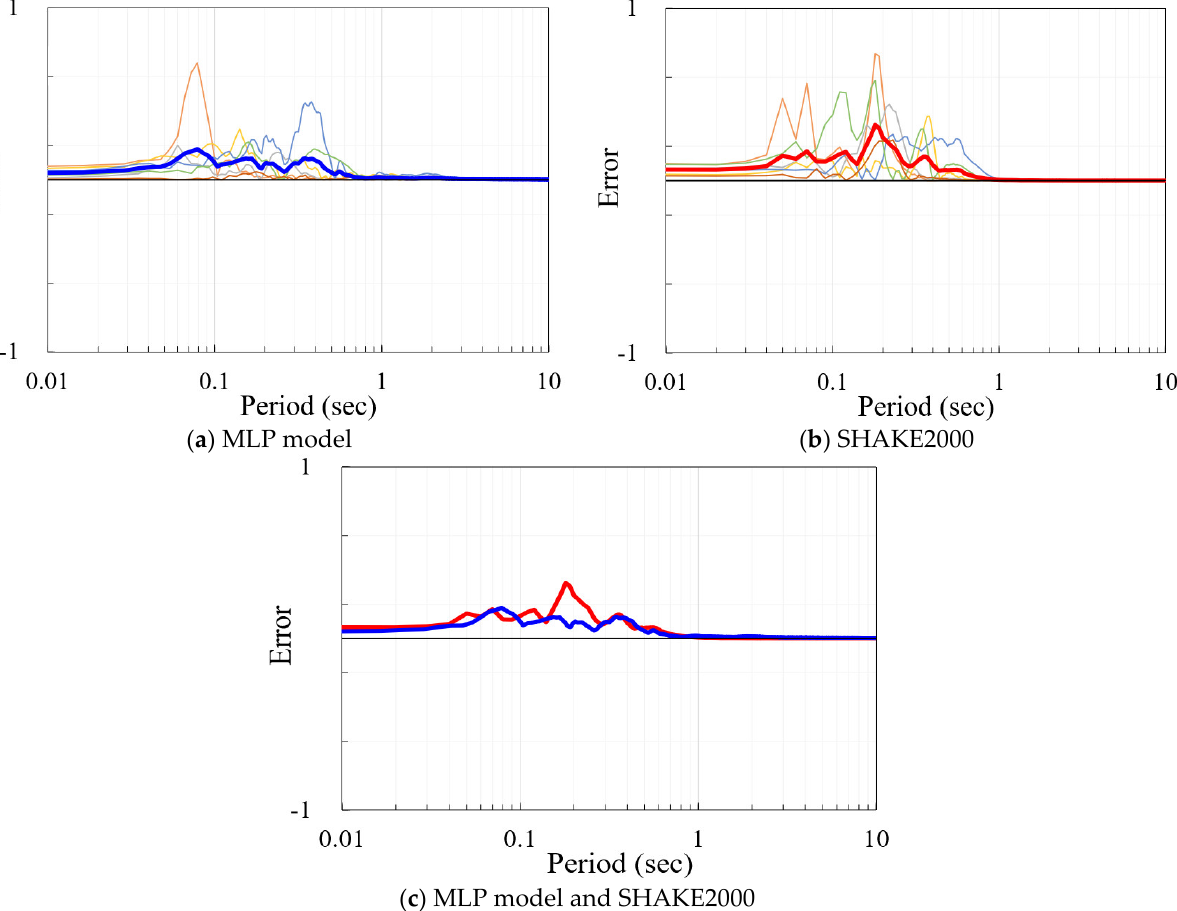
Figure 15. The global errors in the earthquake predictions for all sites.